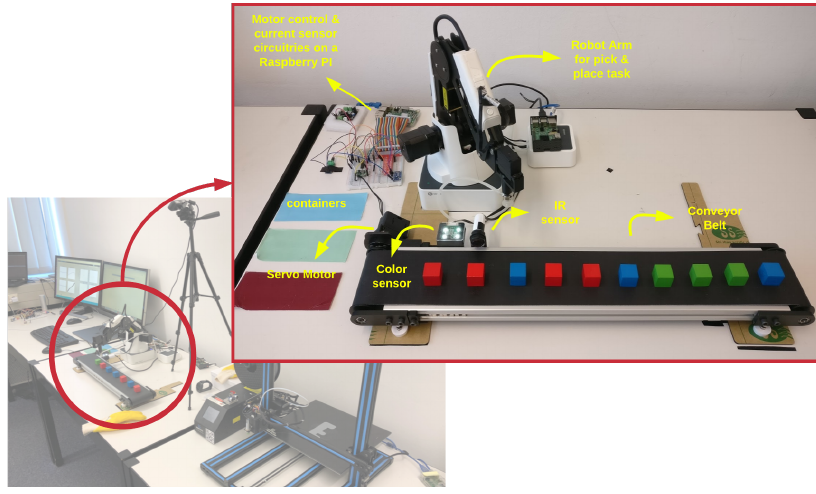
Figure 8. The experiment setup.